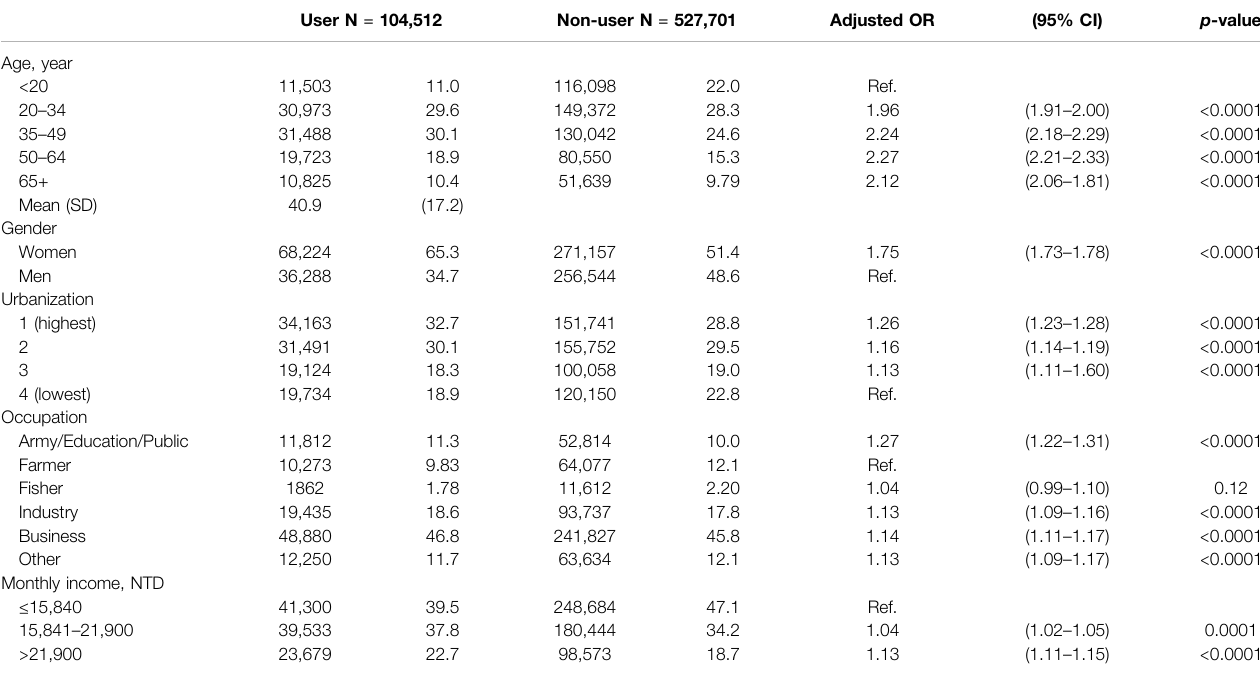
TABLE 1 | Demographic characteristics and multiple logistic regression analysis of radix Salvia miltiorrhiza users from 2000 to 2011 among Taiwan Traditional Chinese Medicine